Question: Generate an informative caption for the figure above.
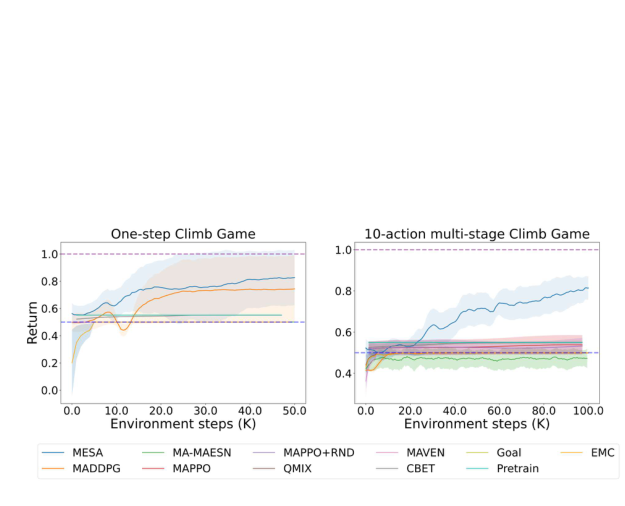
Answer: Learning curve of the two climb game variants w.r.t number of environment steps. The return is averaged over timesteps for the multi-stage games. The dotted lines indi- cate the suboptimal return of 0.5 (purple) and the optimal return 1 (blue) for each agent.